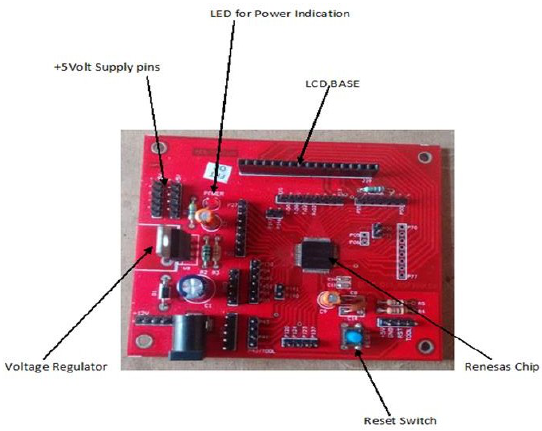
Figure 2. Renesas microcontroller [17]